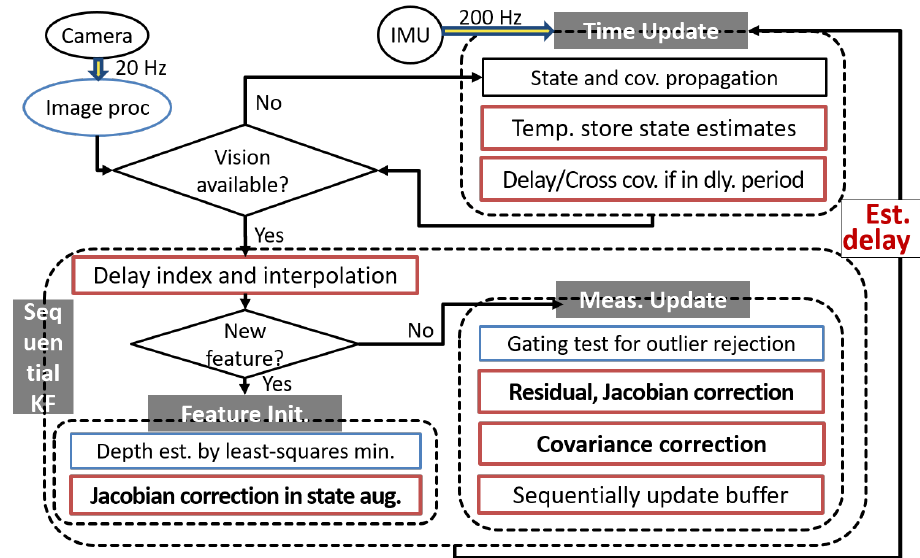
Figure 6. A flow chart of the overall process of the latency compensated